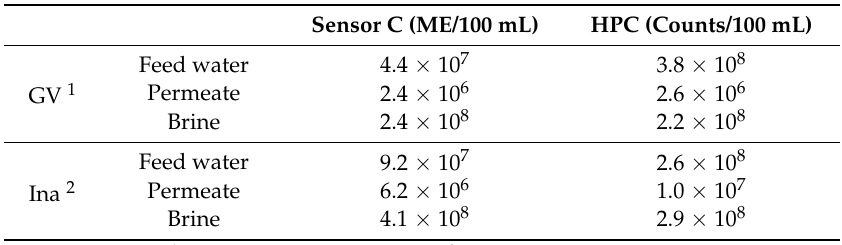
Table 1. Raw microbial counts in waters from Green Valley (GV) and Ina Rd (Ina) WWTPs.